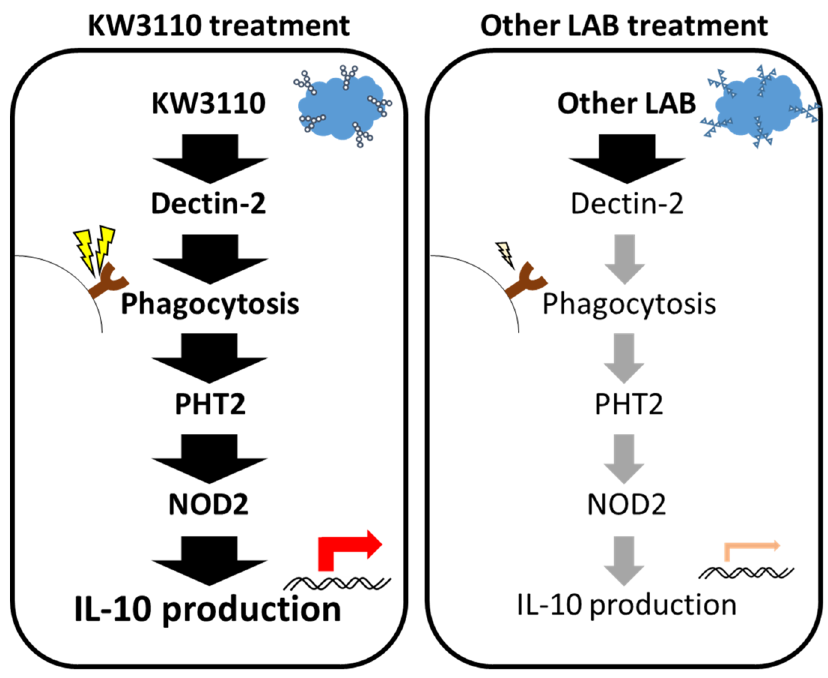
Figure 7. A signaling diagram of IL-10 production by KW3110 in RAW264.7 cells. KW3110 had higher binding affinities to lectins, which recognize the carbohydrate chains comprised of α-mannose, than other LAB. KW3110 is easily incorporated into RAW 264.7 cells. Dectin-2 expression in RAW 264.7 cells has a key role in phagocytosis of KW3110. After phagocytosis, the engulfed KW3110 might reach the cytosol via PHT2 and activate the IL-10 signaling pathway, including